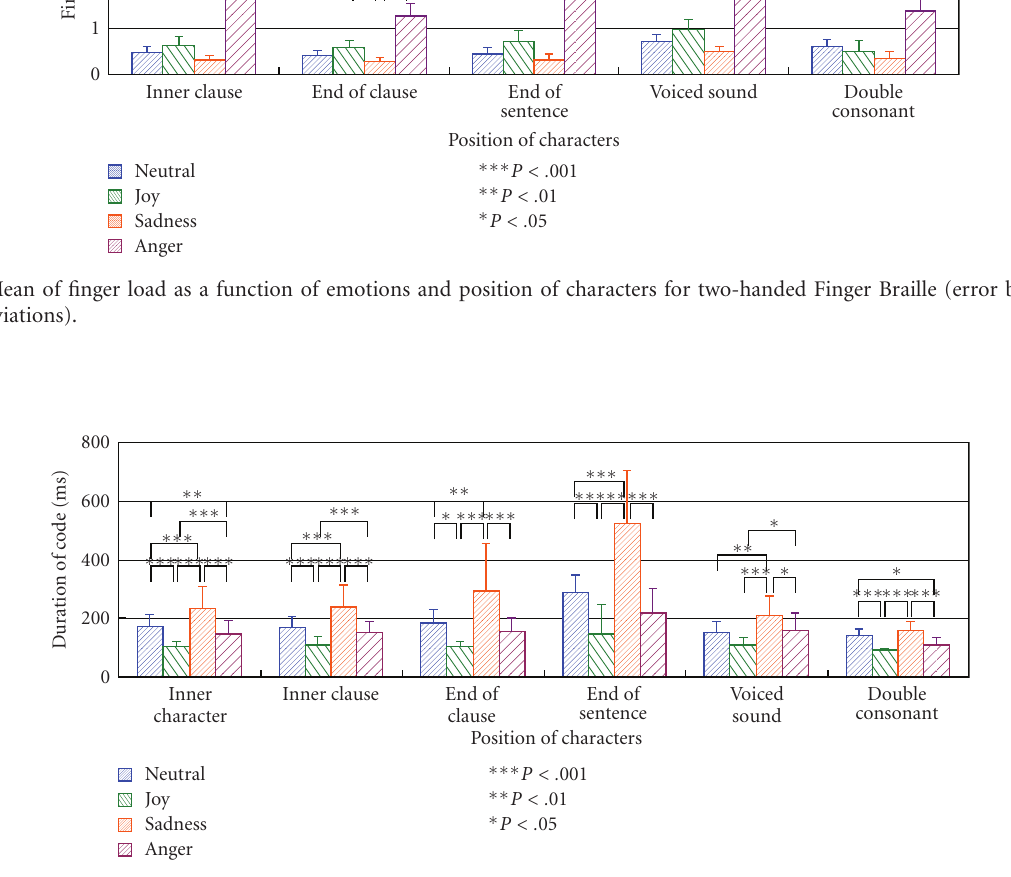
Figure 8: Mean of duration of code as a function of emotions and position of characters for one-handed Finger Braille (error bars represent standard deviations).